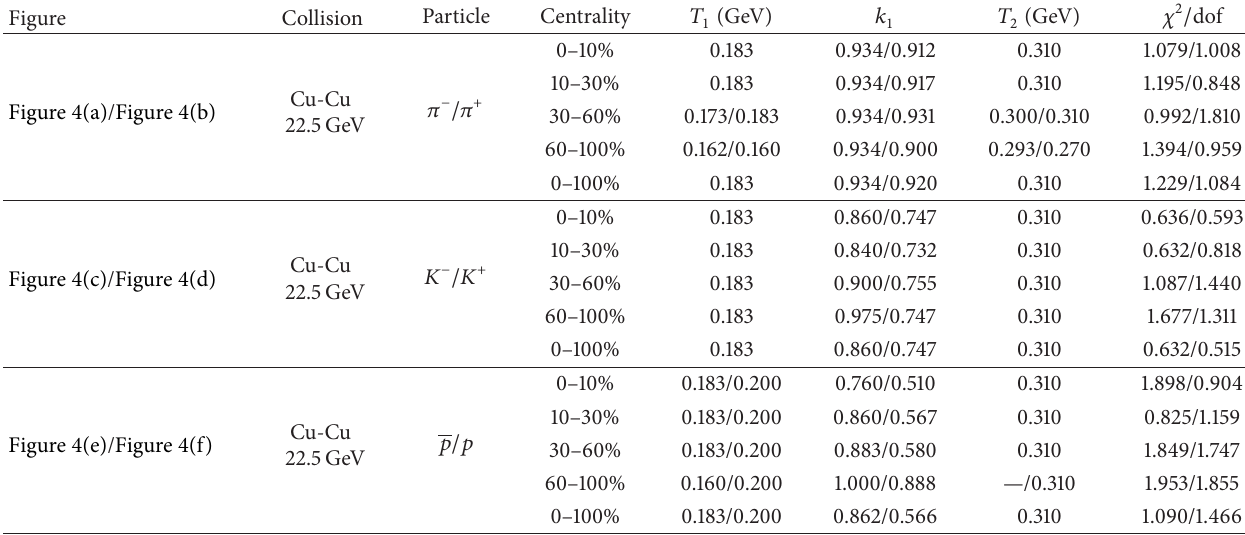
Table 4: Parameter values corresponding to the curves in Figure 4. Figure